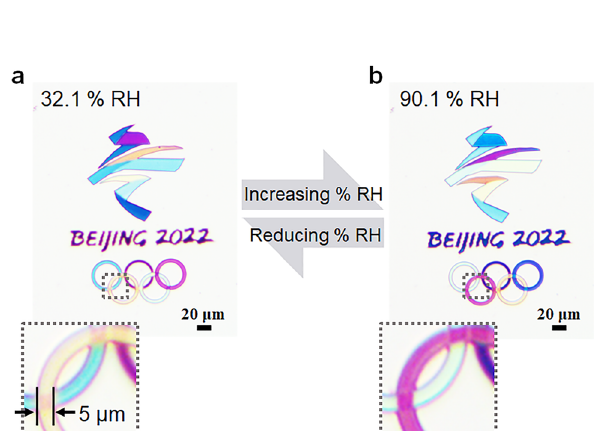
Figure 4: Refection spectra of the structures with the initial H PVA of (a) 133 nm, (b) 184 nm, ( c) 216 nm, and H Pt of 14 nm. Inset shows the actual colors at 32.1 and 90.1% RH. (d) Photograph of multi-color palettes switched with ambient humidity between 32.1 and 90.1% RH.